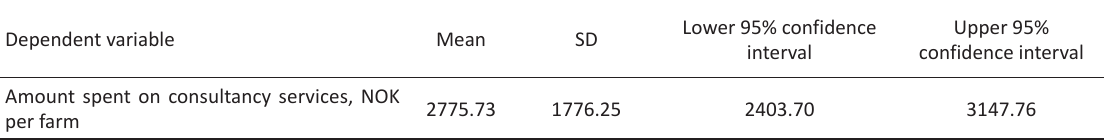
Table 3. Amount spent on dairy consultancy services from Tine SA in 2007 Dependent